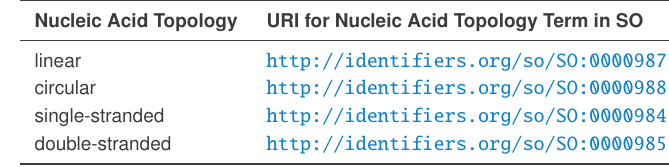
Table 3: Sequence Ontology terms to encode DNA or RNA topology information in types properties of a ComponentDefinition .